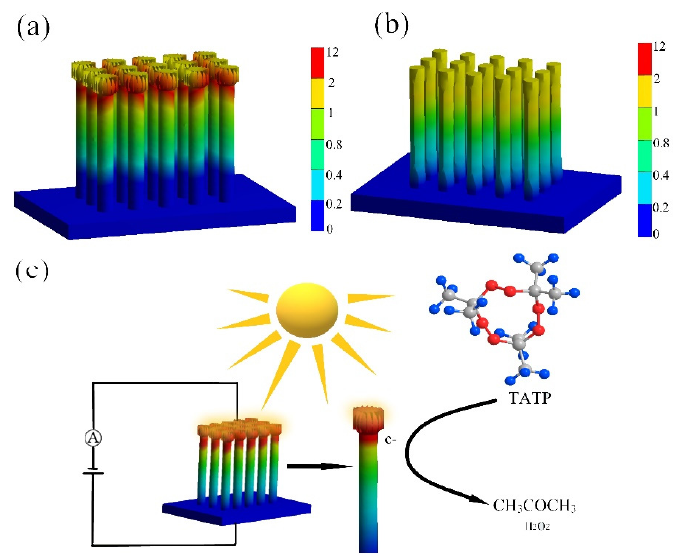
Figure 11. E-field intensity distributions of TiO 2 nanoarray on FTO glass: ( a ) Front view of a TiO 2